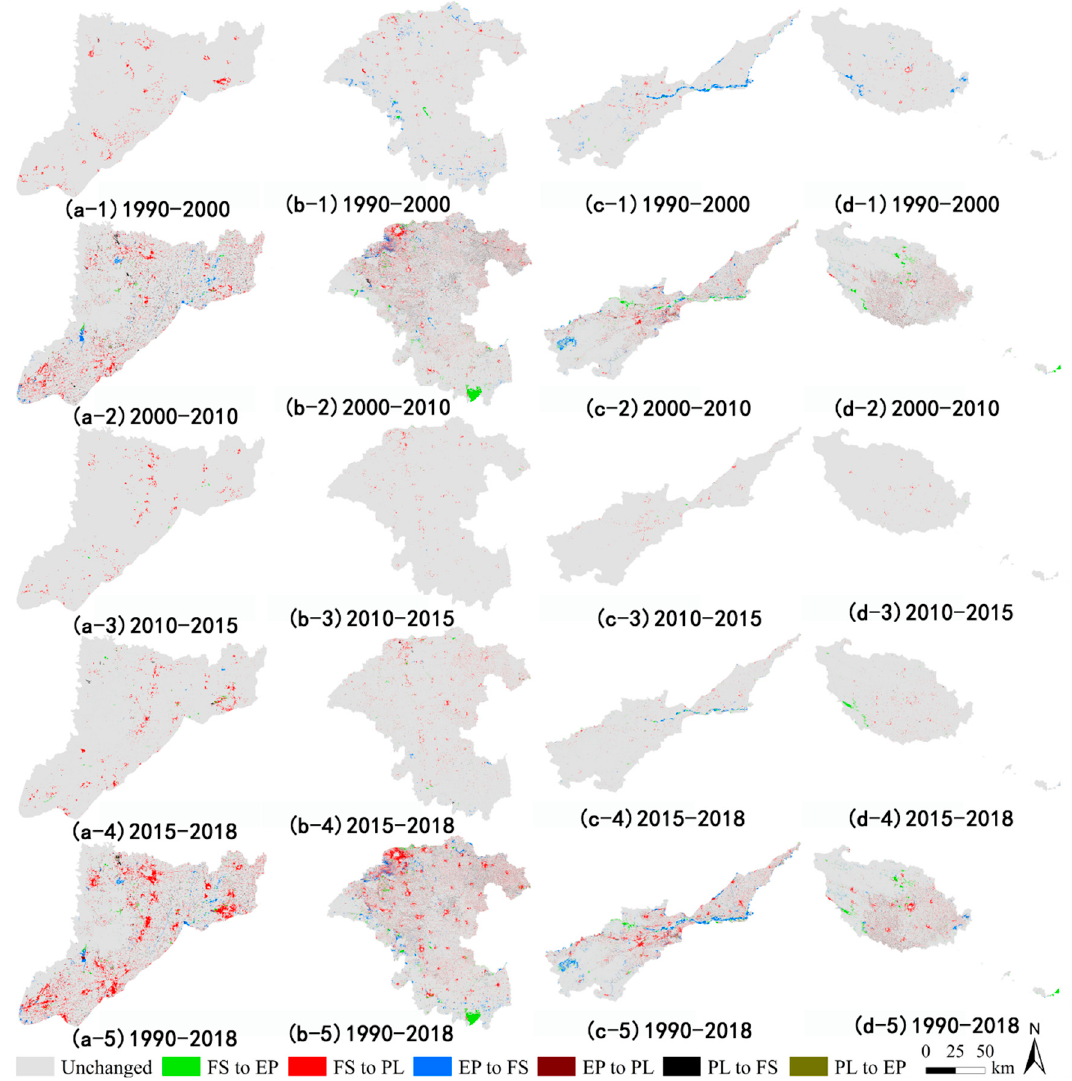
Figure 4. Spatial dynamics of land use/cover (LUCC) in the four basins from 1990 to 2018. ( a-1 ), ( a-2 ), ( a-3 ), ( a-4 ), and ( a-5 ) depict spatial dynamics of LUCC in the HRB; ( b-1 ), ( b-2 ), ( b-3 ), ( b-4 ), and ( b-5 ) depict spatial dynamics of LUCC in the HURB; ( c-1 ), ( c-2 ), ( c-3 ), ( c-4 ), and ( c-5 ) depict spatial dynamics of LUCC in the YERB; ( d-1 ), ( d-2 ), ( d-3 ), ( d-4 ), and ( d-5 ) depict spatial dynamics of LUCC in the YARB. The definition of land-use type abbreviations (FS, EP, PL) can be found in Table 4.